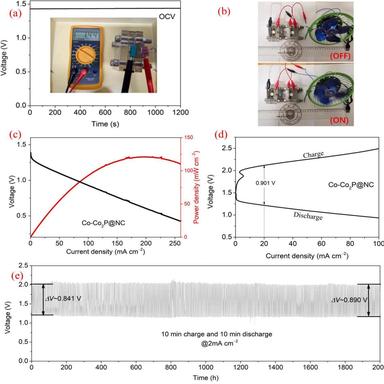
The performance of Co-Co2P @ NC-based aqueous ZAB. (a) OCV plot. (inset: photograph of OCV metered by a multimeter); (b) Photography of a mini-fan powered by two ZABs in series; (c) Discharge current density and power density vs. voltage profiles, respectively; (d) The charge and discharge polarization curves; (e) The galvanostatic charge/ discharge cycling curve.